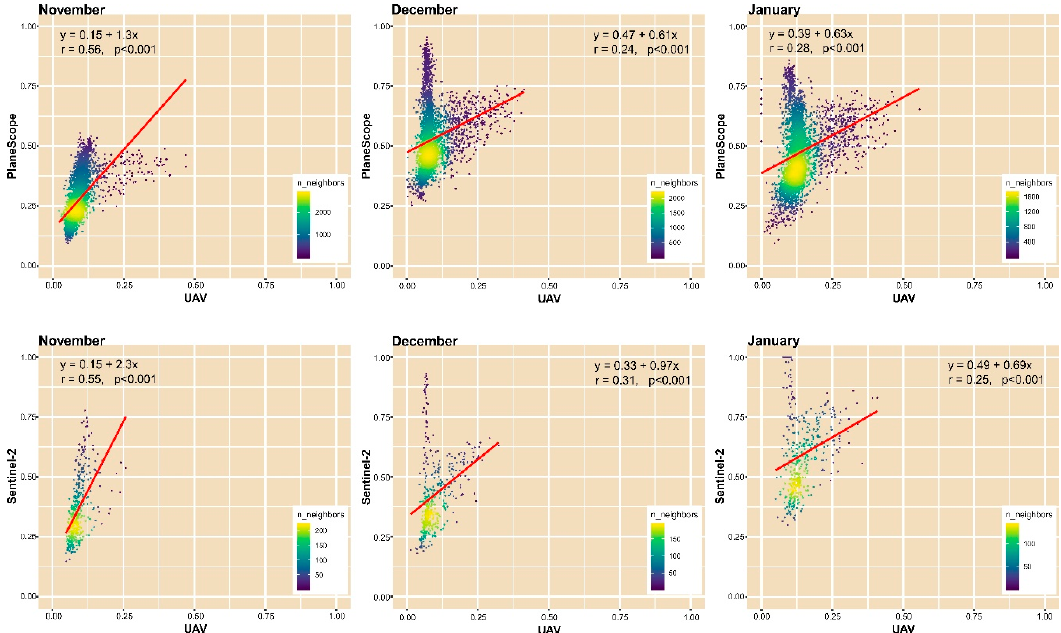
Figure 8. Scatter plots of SAVI values from UAV, considering only soil pixels (SAVI soil) (x-axis), PlanetScope, and Sentinel-2 maps in the three months surveyed.